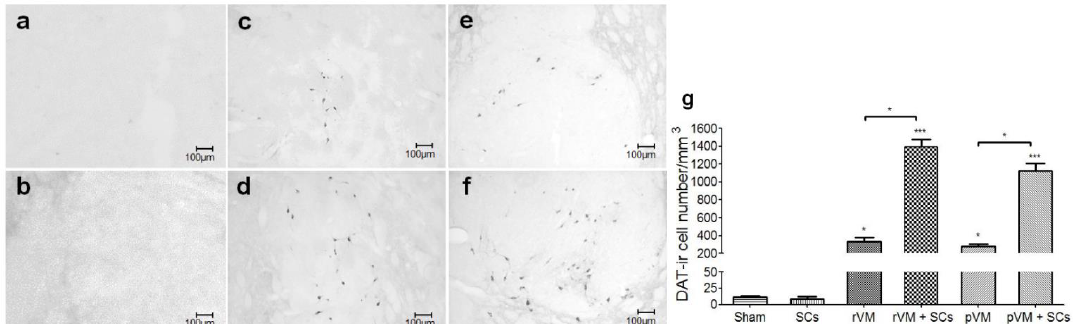
Figure 8. Photomicrographs of DAT-ir and quantification results at four weeks after transplantation. DAT-ir cell bodies in the grafted sides of the rVM, rVM+SCs, pVM, and pVM+SCs groups. The densities of DAT-ir cell bodies in the rVM+SCs and pVM+SCs groups were higher than those of the rVM and pVM groups. Quantification data were consistent with the IHC results. ( a ) Sham group. ( b ) SC group. ( c ) rVM group. ( d ) rVM+SCs group. ( e ) pVM group. ( f ) pVM+SCs group. ( g ) Quantification of DAT-ir cell density. ( h ) OD ratio in grafted striatum (* p < 0.05; *** p < 0.01). Scale bar = 100 μ m.